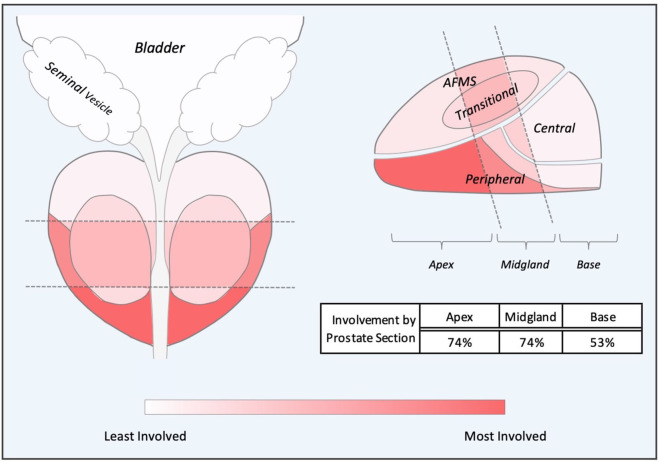
Composite Representations of Localized Failures. A depiction of the prostate, seminal vesicles and bladder shown in coronal and sagittal orientations without laterality. The prostate is subdivided into apex, midgland, and base sections and further subdivided into peripheral, transitional, central and anterior fibromuscular stroma (AFMS) prostatic zones. Sections and zones are overlaid with a color-represented heatmap representing degree of cancer recurrence involvement.